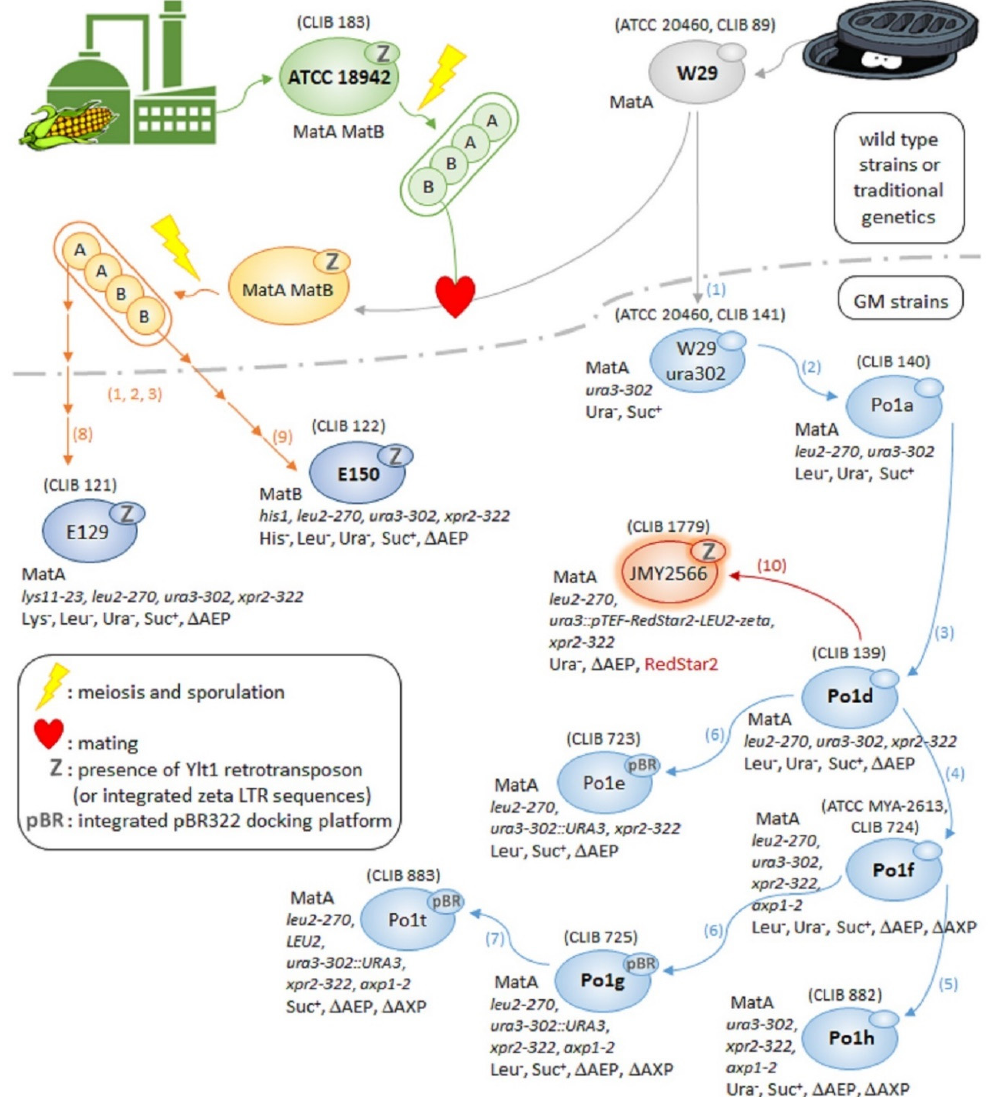
Figure 2. Genealogy of strains of biotechnological interest derived from ATCC 18942 and/or W29. Schematic representation of the origins of ATCC 18942 and W29 wild-type strains and their publicly available derivatives: genotypes and phenotypes are indicated near each strain; yeast collection reference numbers are shown only for ATCC and CLIB-Levures (others can be found in Table 1). Genetic events are represented by the lightning and heart symbols; the presence of sequences that can be used for targeting integrations (zeta sequences, plasmidic backbone) is indicated in the nascent yeast bud. The genetic engineering steps are indicated by bracketed numbers, as follows: (1) genic conversion of URA3 into ura3-302 (corresponding to ura3:: p XPR2:SUC2 , namely to a 728 bp Xho I- Eco RV deletion in URA3 coding region with disruption by the SUC2 gene from S. cerevisiae under the control of the XPR2 promoter, conferring the ability to grow on sucrose or molasses) [15]; (2) genic conversion of LEU2 into leu2-270 (681 bp Stu I deletion in LEU2 coding region); (3) genic conversion of XPR2 into xpr2-322 (149 bp Apa I deletion in XPR2 coding region, inactivating alkaline extracellular protease); (4) genic conversion of AXP1 into axp1-2 (655 bp Nco I deletion in AXP1 coding region, inactivating acid extracellular protease); (5) genic conversion of leu2-270 into LEU2 (restoration of wild-type allele); (6) integration of Nco I-linearized pINA300’ plasmid ( URA3 gene in pBR322 [173]); (7) integration of Not I-linearized LEU2 -carrying pINA1269 plasmid [159] at pBR docking platform; (8) genic conversion of LYS11 into lys11-23 ; (9) genic conversion of HIS1 into his1 ; (10) genic conversion of ura3-302 into ura3::pTEF-RedStar2-LEU2-zeta (replacement of the SUC2 expression cassette disrupting URA3 with two cassettes, for expressing the RedStar2 fluorescent protein from TEF promoter and for LEU2 , and a zeta LTR sequences docking platform) [162]. The names of the more prominent strains are in bold type. Information gathered from [10,43] or ATCC and CLIB-Levures websites.